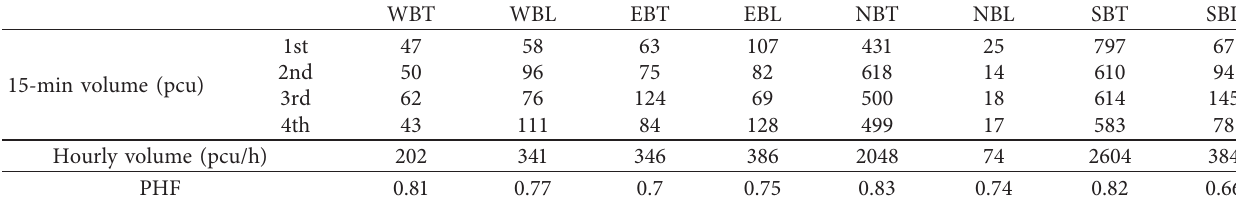
Table 1: Traffic volumes at Huanggang-Fuzhong intersection.